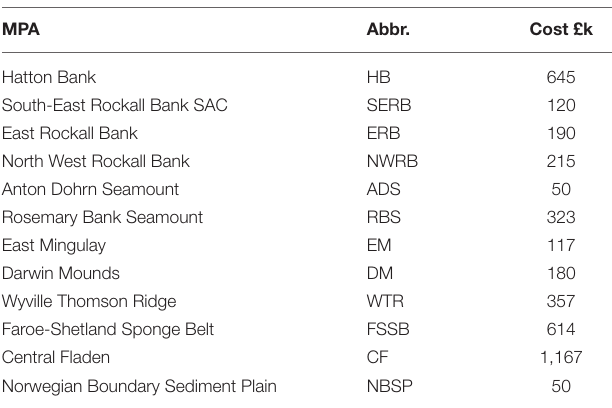
TABLE 1 | Estimated annual costs associated with Scottish MPAs (thousands of £). MPA